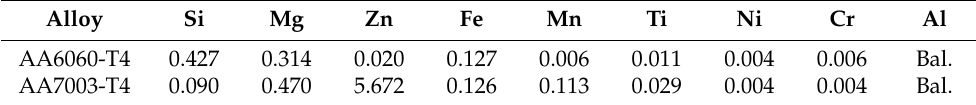
Table 1. Chemical composition of the experimental alloys (wt